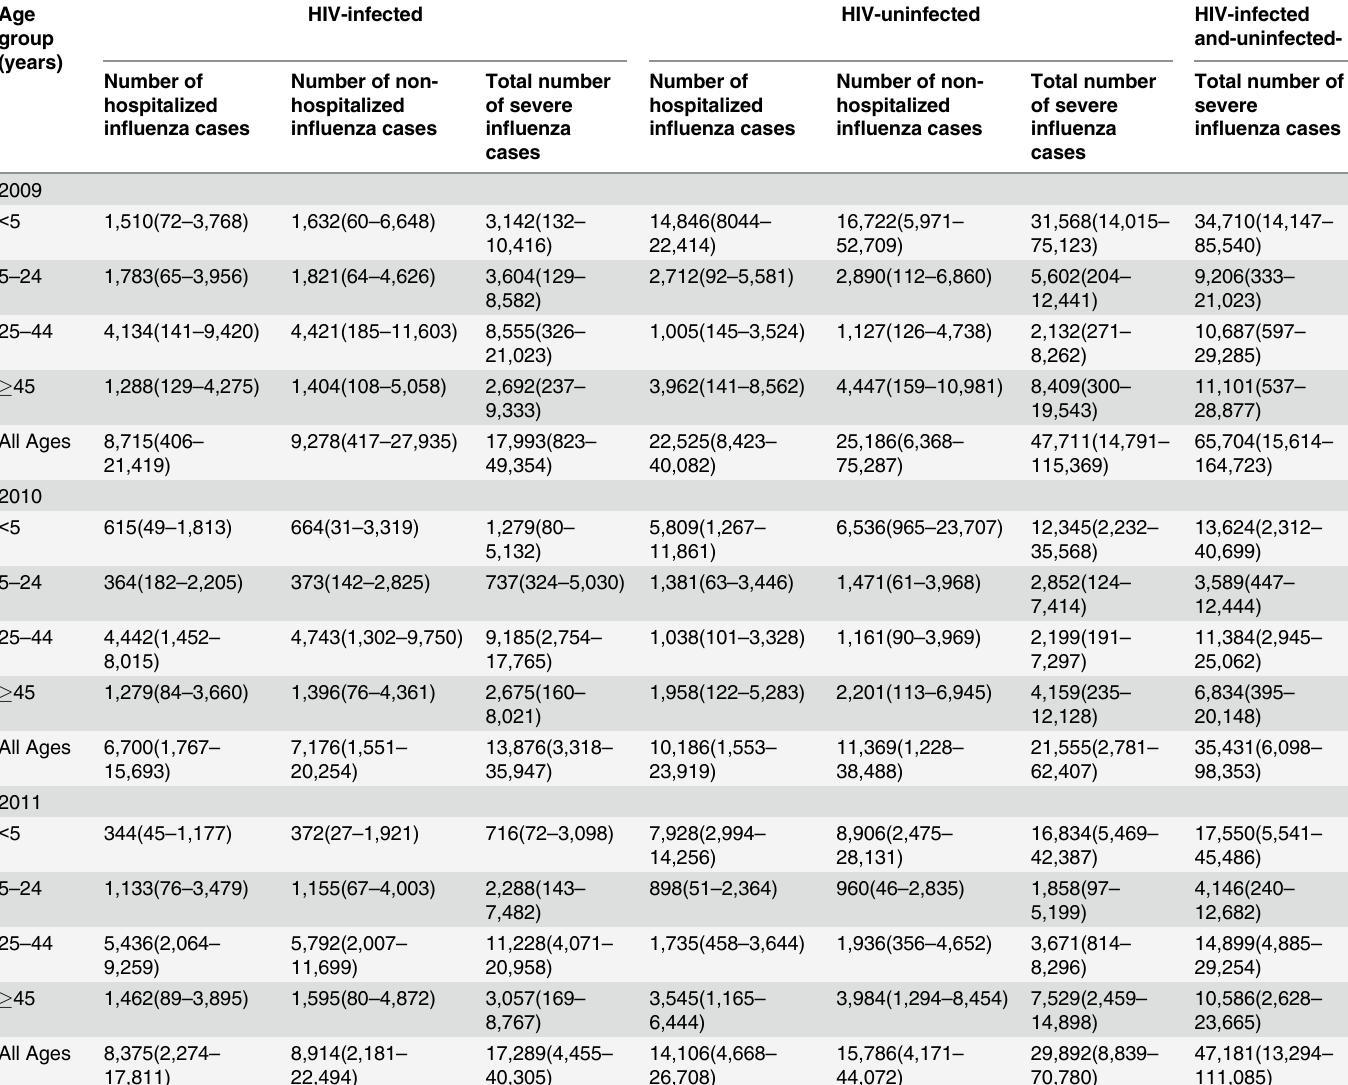
Table 2. Estimated national number (95% C.I.) of hospitalized and non-hospitalized influenza-associated severe acute respiratory illness (SARI) cases, stratified by HIV serostatus, South Africa, 2009 –